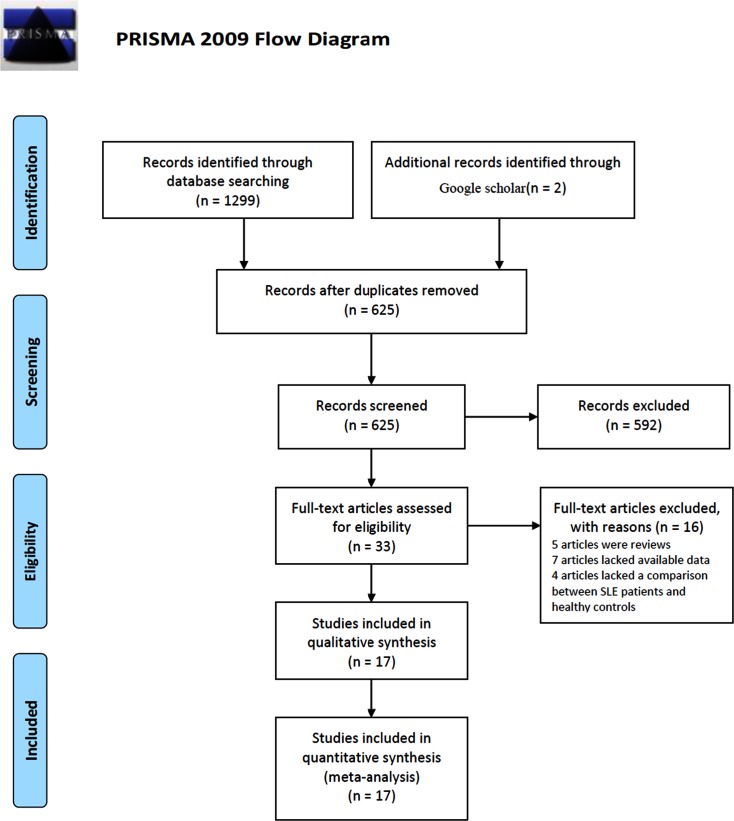
Flow diagram of the study selection process.From: Moher D, Liberati A, Tetzlaff J, Altman DG, The PRISMA Group (2009). Preferred Reporting Items for Systematic Reviews and Meta-Analyses: The PRISMA Statement. PLoS Med. 6(7): e1000097. doi: 10.1371/journal.pmed1000097. For more information, visit www.prisma-statement.org.